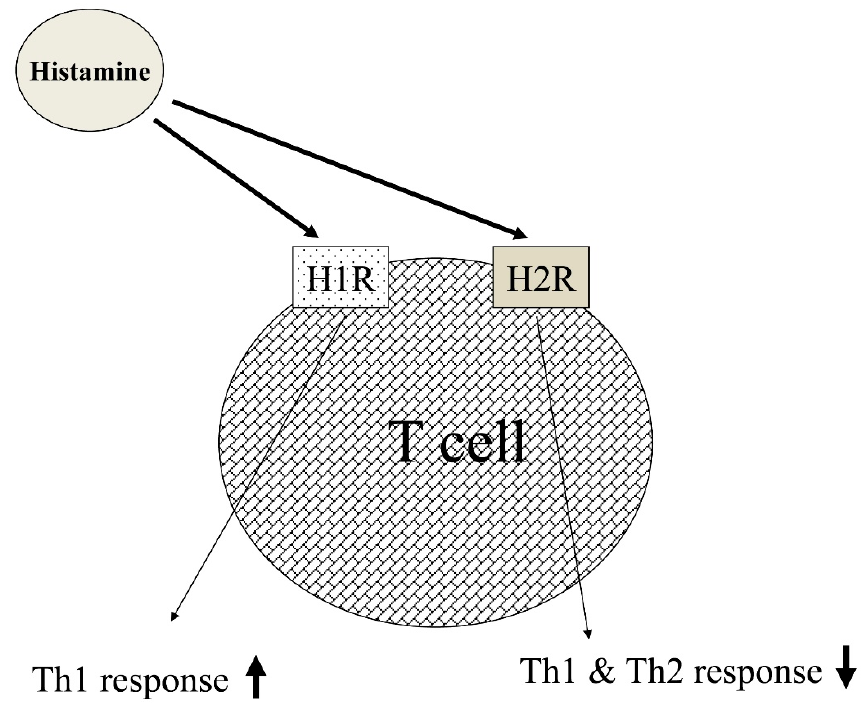
Figure 6. Regulation of Th1 and Th2 responses by histamine via H1R and H2R.